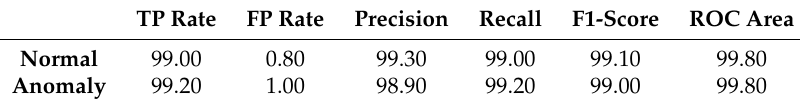
Table 30. Classification report for Adaboost Random